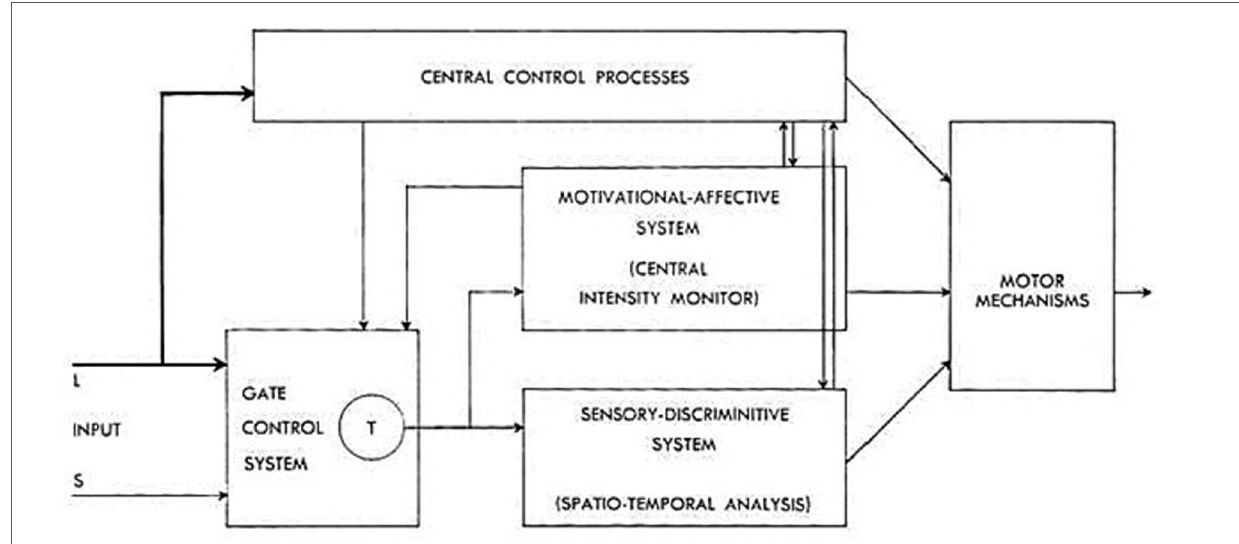
FIGURE 1 ORIGINAL FIGURE 20.3 (WITH